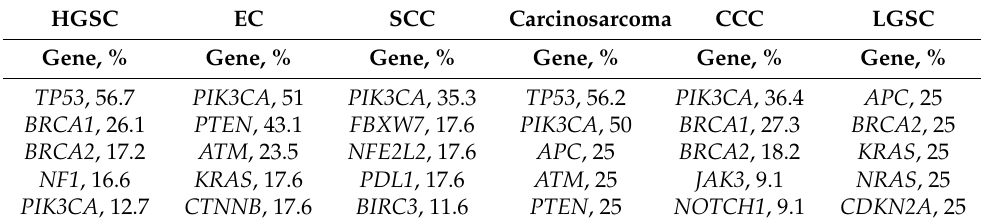
Table 2. Frequently altered genes in common tumor subtypes of our study population.